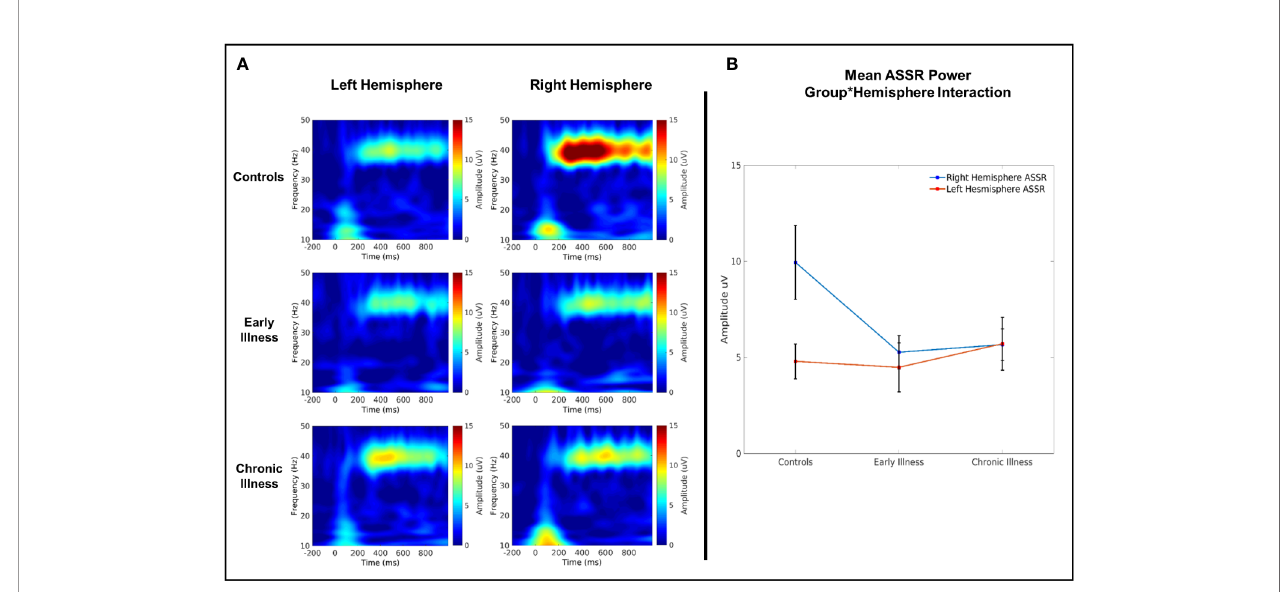
FIGURE 5 | (A) Time – frequency plots of left and right auditory cortical 40 Hz ASSR amplitude. (B) 40 Hz evoked amplitude across